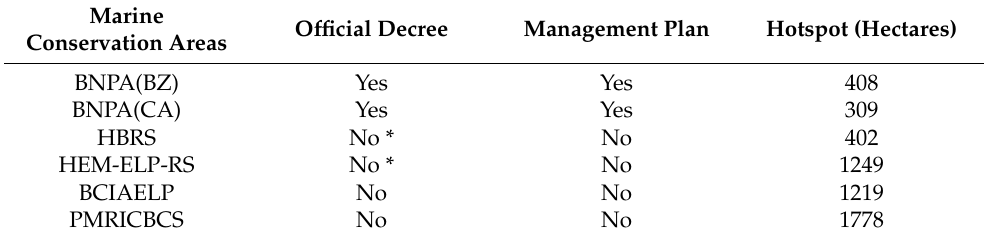
Figure 4. Hotspot distribution model. Fish hotspot ( ≥ 60 species per hectare) is about 1778 Ha. Only 17% of the hotspot is within the core area of the Balandra Natural Protected Area (yellow polygon). The green polygon corresponds to the buffer zone. Table 1. Hotspot area within marine conservation areas and their conservation policy legal status. * Only with international registration. BNPA(BZ): Balandra Natural Protected Area (buffer zone); BNPA(CA): Balandra Natural Protected Area (core area); HBRS: Humedal Balandra Ramsar Site; HEM-ELP-RS: Humedal El Mogote-Ensenada de La Paz Ramsar Site; BCIAELP: Bird Conservation Importance Area Ensenada de La Paz; PMRICBCS: Priority Marine Region Insular Complex of Baja California Sur.